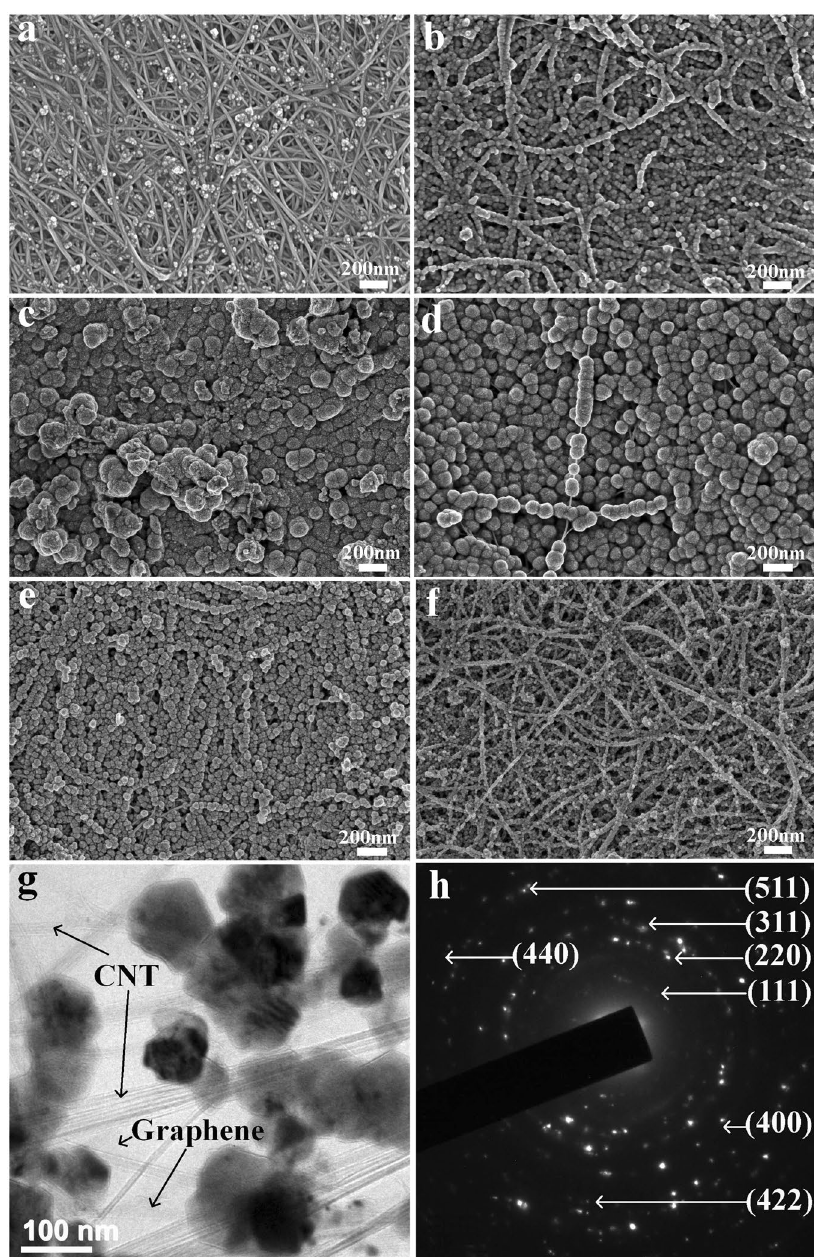
Figure 1. Scanning electron microscope images of the composite prepared at FeCl 3 concentrations of 0.01– 0.10 M: ( a ) 0.01 M, ( b ) 0.02 M, ( c ) 0.03 M, ( d ) 0.04 M, ( e ) 0.05 M and ( f ) 0.10 M. ( g ) Transmission electron microscopy of CNT film-Fe 3 O 4 -0.04 M-graphene. ( h ) The selected-area electron diffraction pattern of Fe 3 O 4